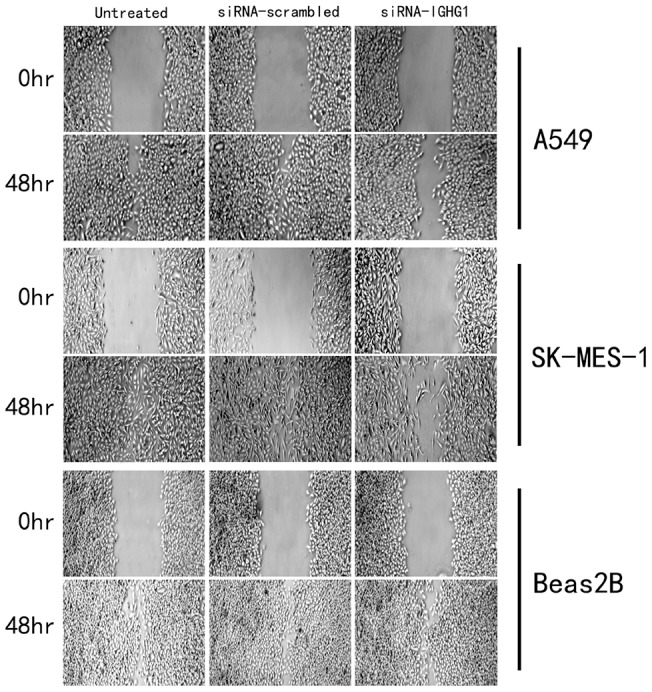
IgG down-regulation inhibits cell migration by wound healing assay in lung cancer cells.Forty-eight hours after scratching the cultured cells, scratched areas were photographed. The results show that for the untreated and siRNA-scrambled groups, the wound area is markedly narrowed in A549 and SK-MES-1 but not in Beas2B.